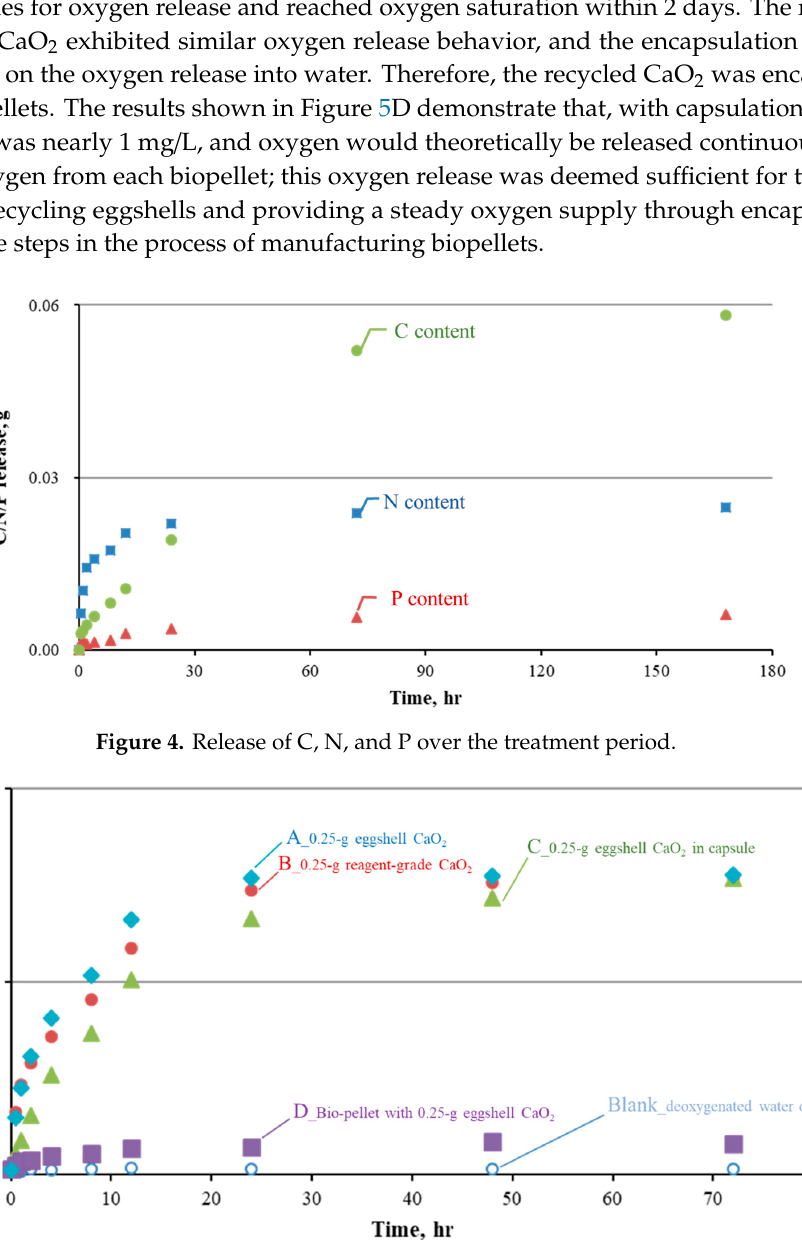
Figure 5. Oxygen released from ( a ) eggshell-derived CaO 2 , ( b ) reagent-grade CaO 2 , ( c ) encapsulated eggshell-derived CaO 2 , ( d ) eggshell-derived CaO 2 in a biopellet, and a blank.